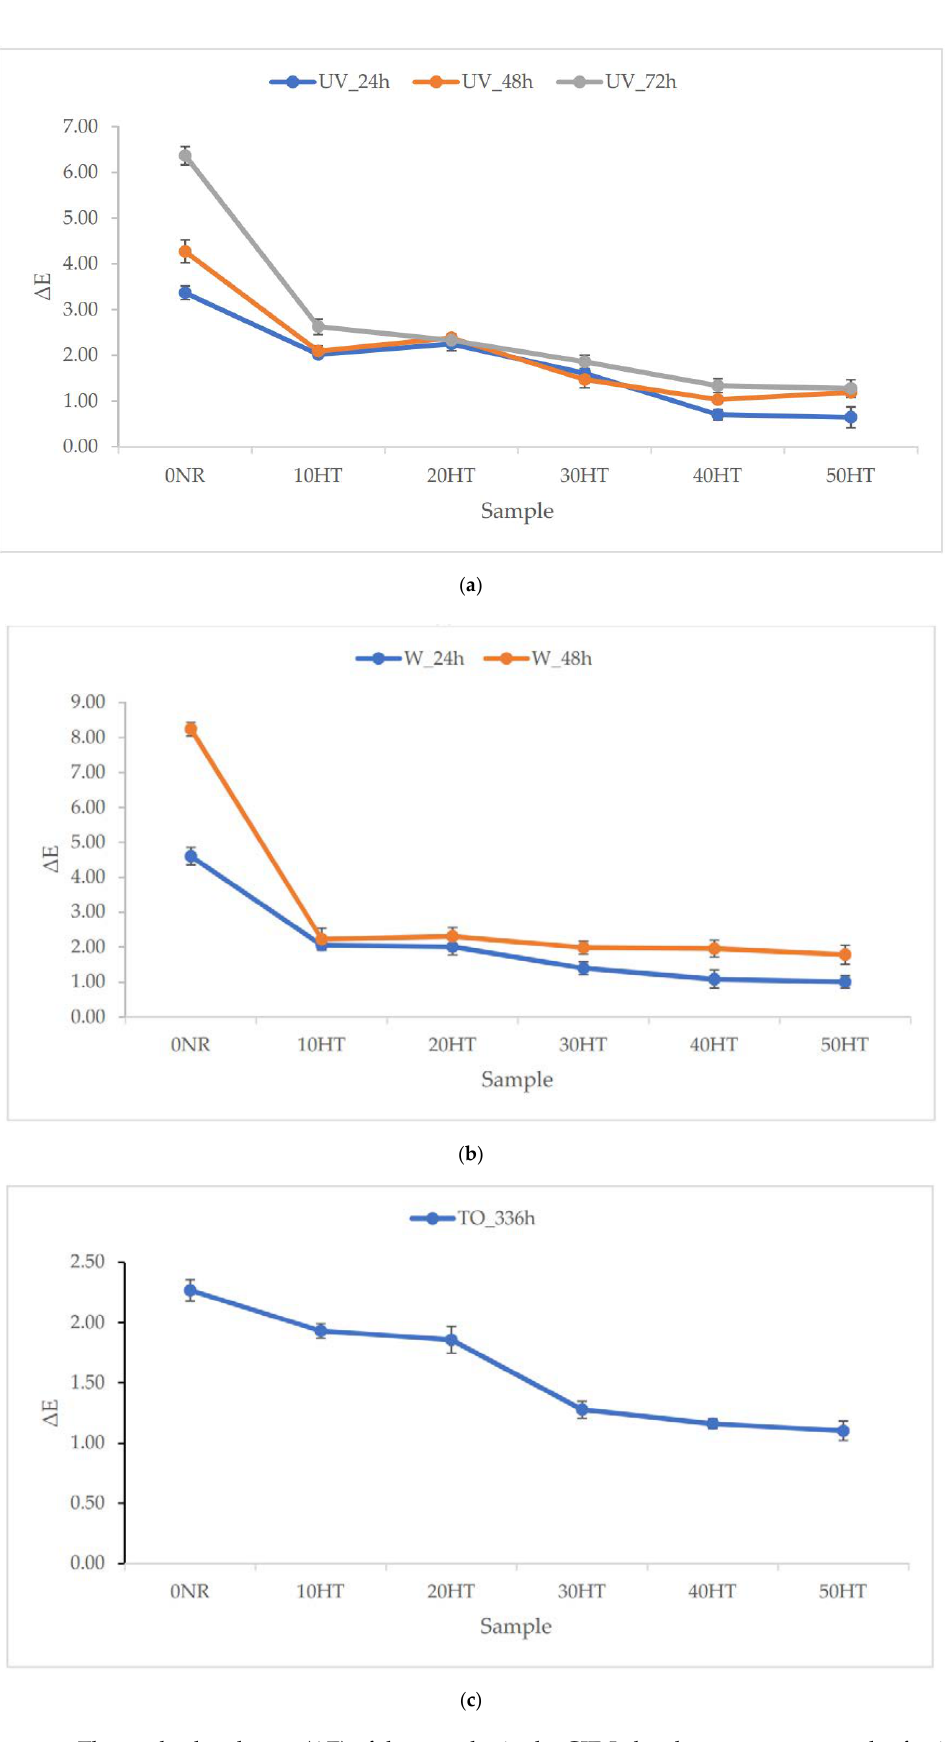
Figure 10. The total color change ( ∆ E) of the samples in the CIE-Lab color system as a result of aging processes ( a ) UV, ( b ) weathering, ( c ) thermo-oxidative.